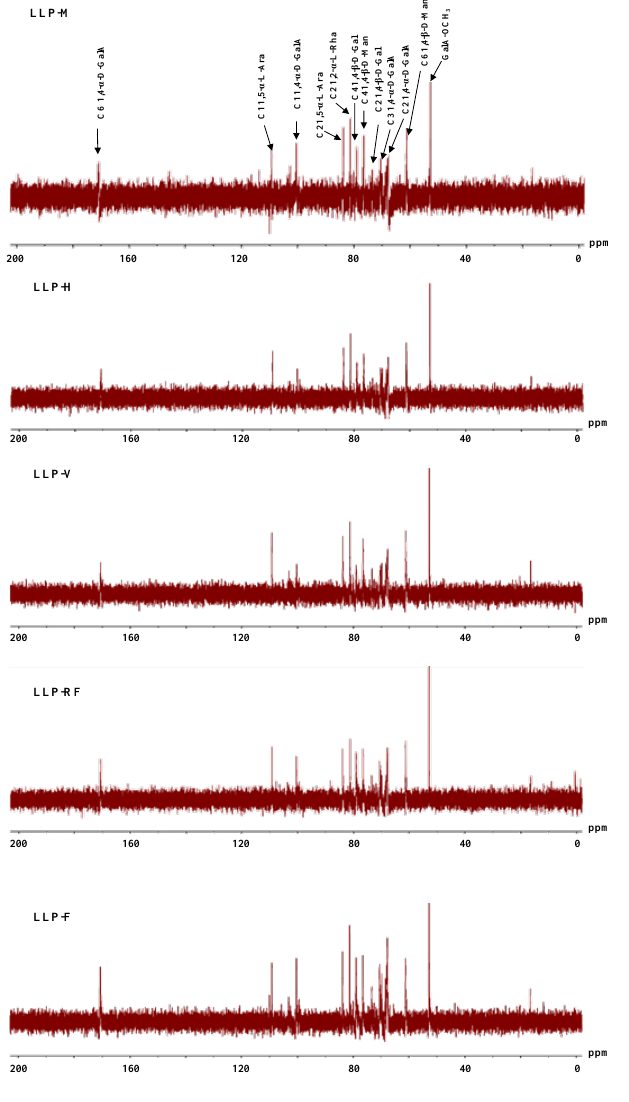
Figure 4. 13 C NMR spectra of LLPs.